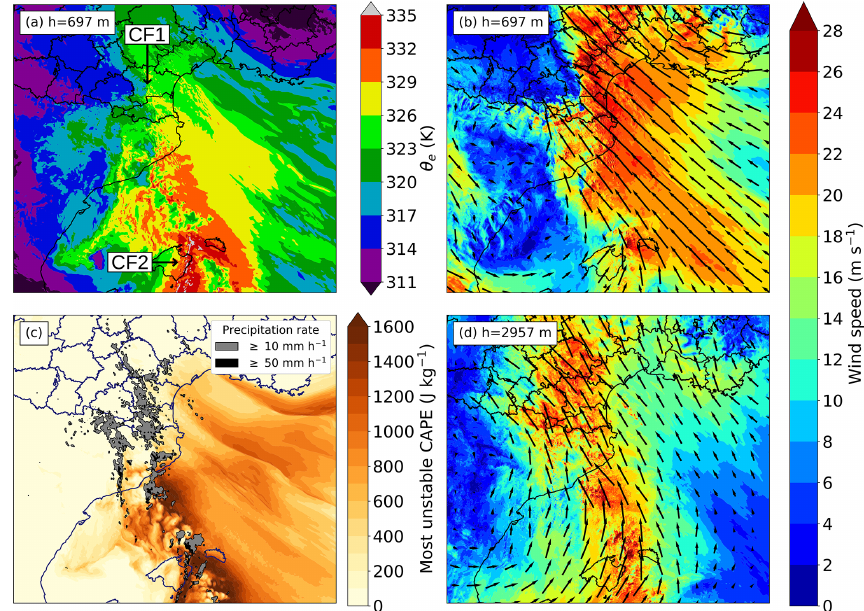
Figure 10. REF simulation at 00:00UTC on 15 October of (a) equivalent potential temperature ( θ e ) at 697m height, (b) wind at 697m height, (c) MUCAPE with instantaneous precipitation rate and (d) wind at 2957m